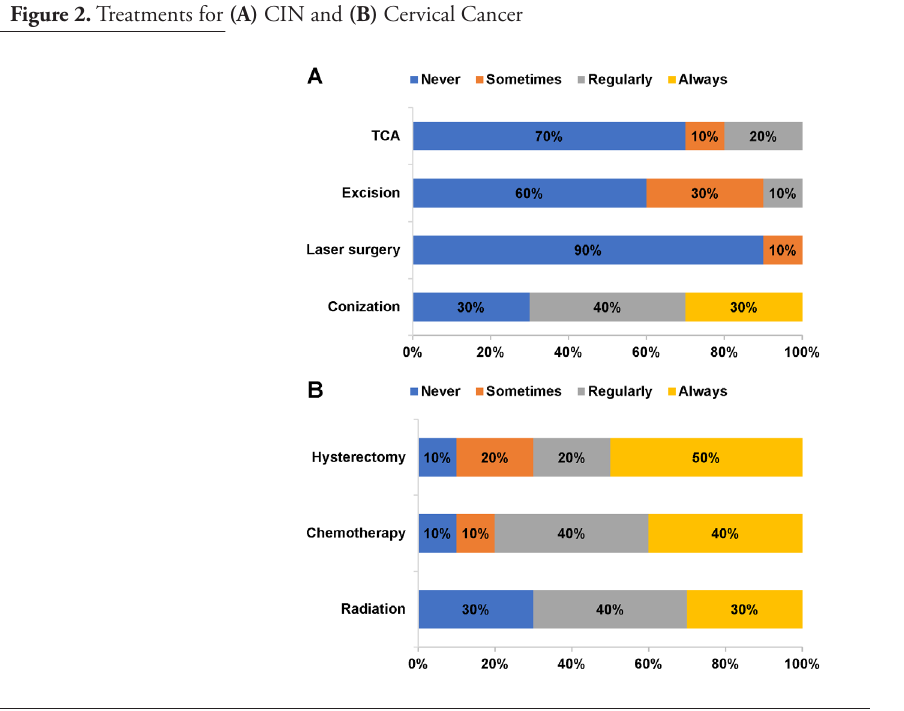
Figure 2. Treatments for (A) CIN and (B) Cervical